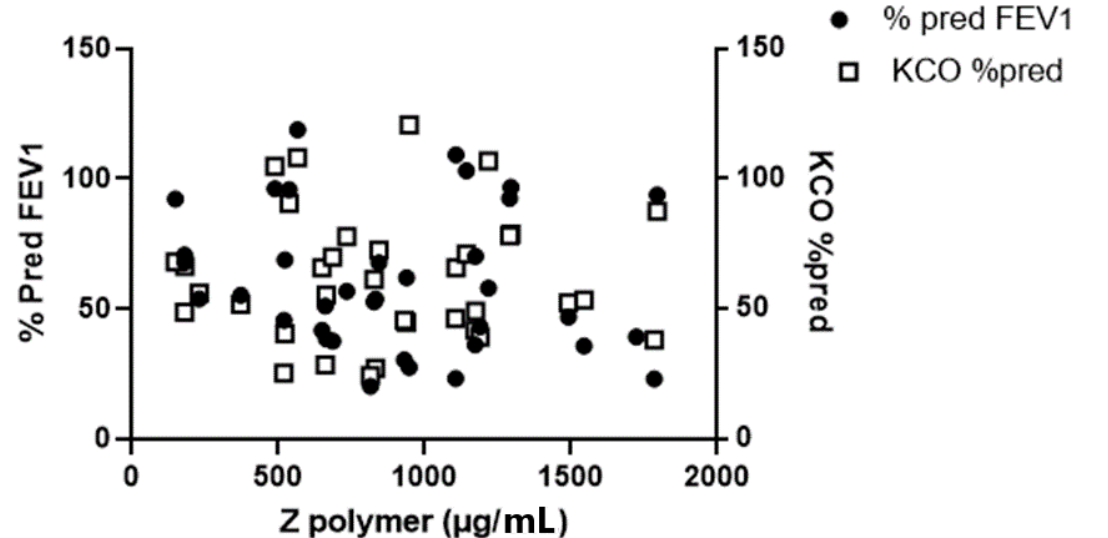
Figure 1. Pulmonary function of 52 ZZ-AATD patients was measured 15 min after the inhalation of 400 µ g of salbutamol followed by spirometry and a CO diffusion gas transfer. Levels of plasma Z-AAT polymers ( µ g/mL) were measured by ELISA based on LG96 mAb (see materials and methods). There was no correlation between plasma Z-AAT polymer values and FEV1 % pred, or Kco % pred. As a control, we measured plasma Z-AAT polymer levels in patients with phenotype SZ and genotype Mheerlen AATD variants (Figure 2).